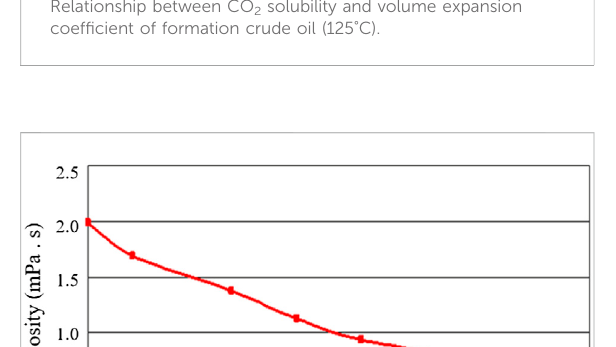
FIGURE 1 Relationship between CO 2 solubility and saturation pressure of formation crude oil (125 ° C).